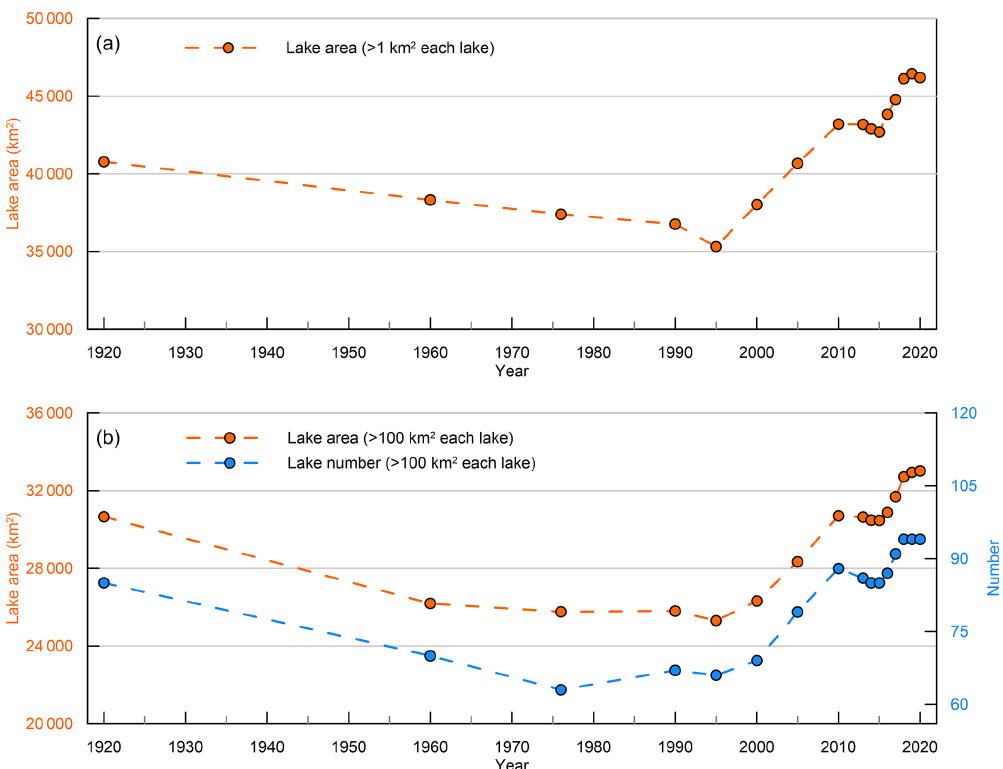
Figure 8. Changes in number and area of lakes from 1920 to 2020. (a) Total area of all lakes greater than 1km 2 . (b) Total area and number of lakes greater than 100km 2 to exclude the effects of variability in the number and area of small lakes (1–100km 2